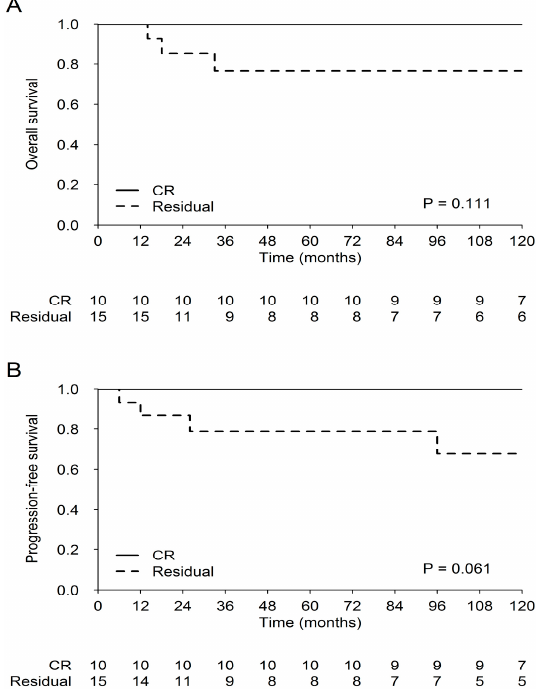
Figure 3. Overall Survival ( A ) and Progression-free Survival ( B ) according to response after 4 PEB (cisplatin/etoposide/bleomycin) cycles.